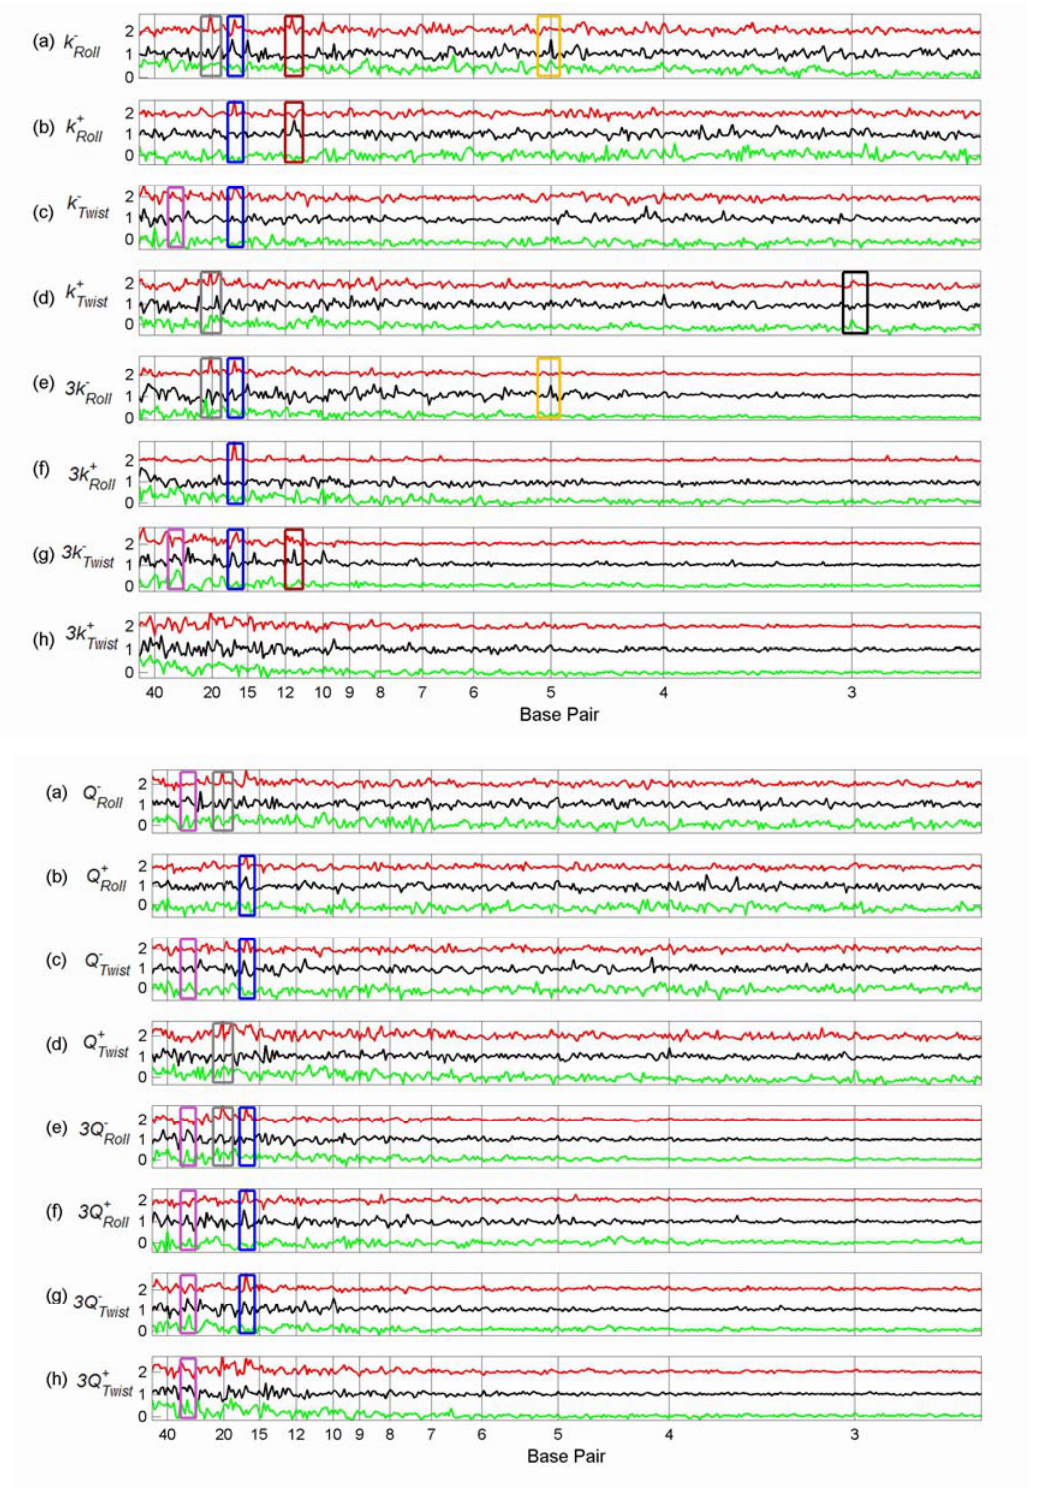
Figures 3-5. Comparison between Flexibility Force Constant Difference Spectra, Partition Coefficient Difference Spectra and Non-flexibility Property Difference Spectra of Tfbs in Chromosome